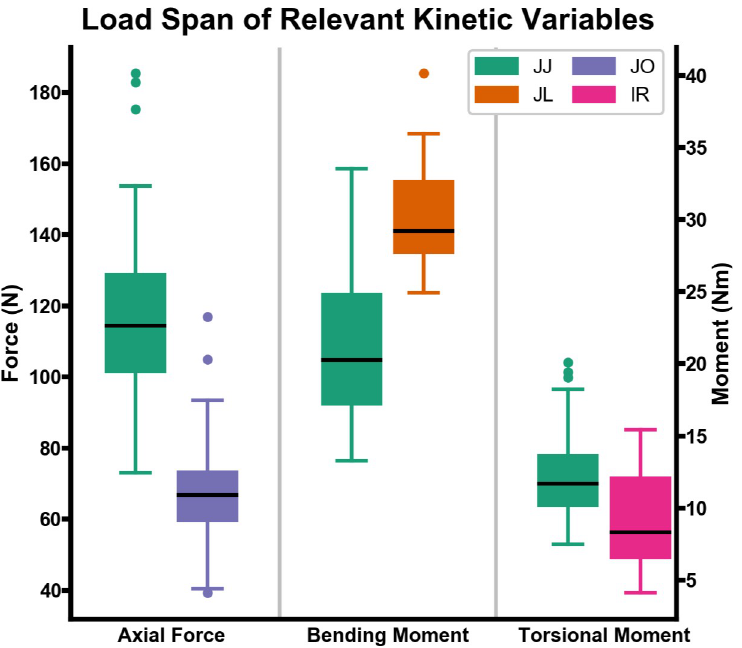
Fig 8. Boxplots of load span for axial force, bending moment, and torsional moment. For jumping jacks (JJ), jug lifts (JL), jogging (JO), and internal rotation (IR) trials the span (max-min) of the applicable kinetic variable is